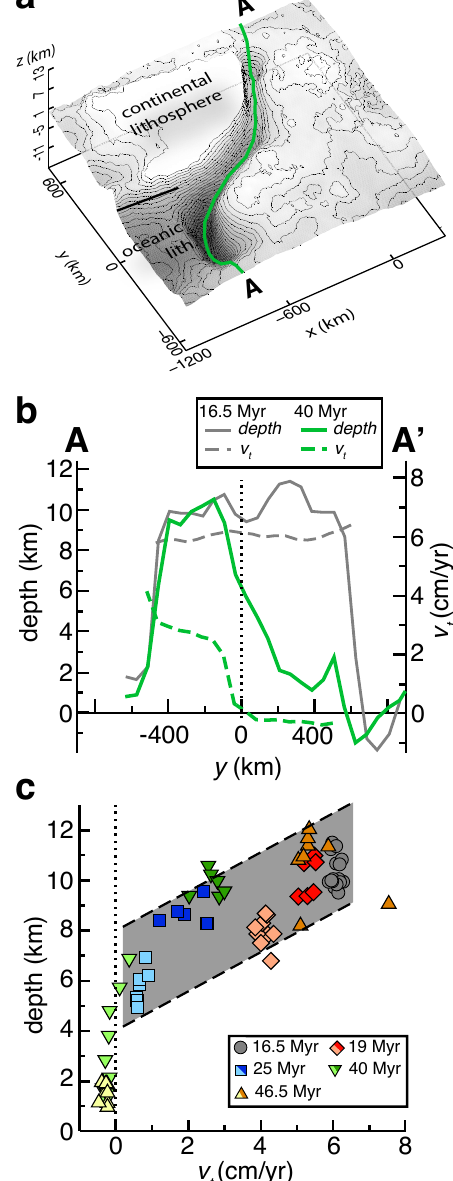
Fig. 5. (a) Digital Elevation Model for the surface of model 11 after 40Myr of subduction. Zero is the average elevation of the glu- cose syrup away from the subduction zone. (b) Maximum trench depth (solid line) and corresponding trench migration rate along y-direction (dashed line) after 16.5Myr (in gray) and 40Myr (in green) of subduction. (c) Trench maximum depth as function of v t at different times during subduction. Light and dark symbols corre- spond to points located in front of continental and oceanic units, re- spectively. To minimise boundary effects, only points located within a distance of 400km from the centre of the subduction zone are in- cluded. Dashed lines and grey box indicate the regression envelope for v t >